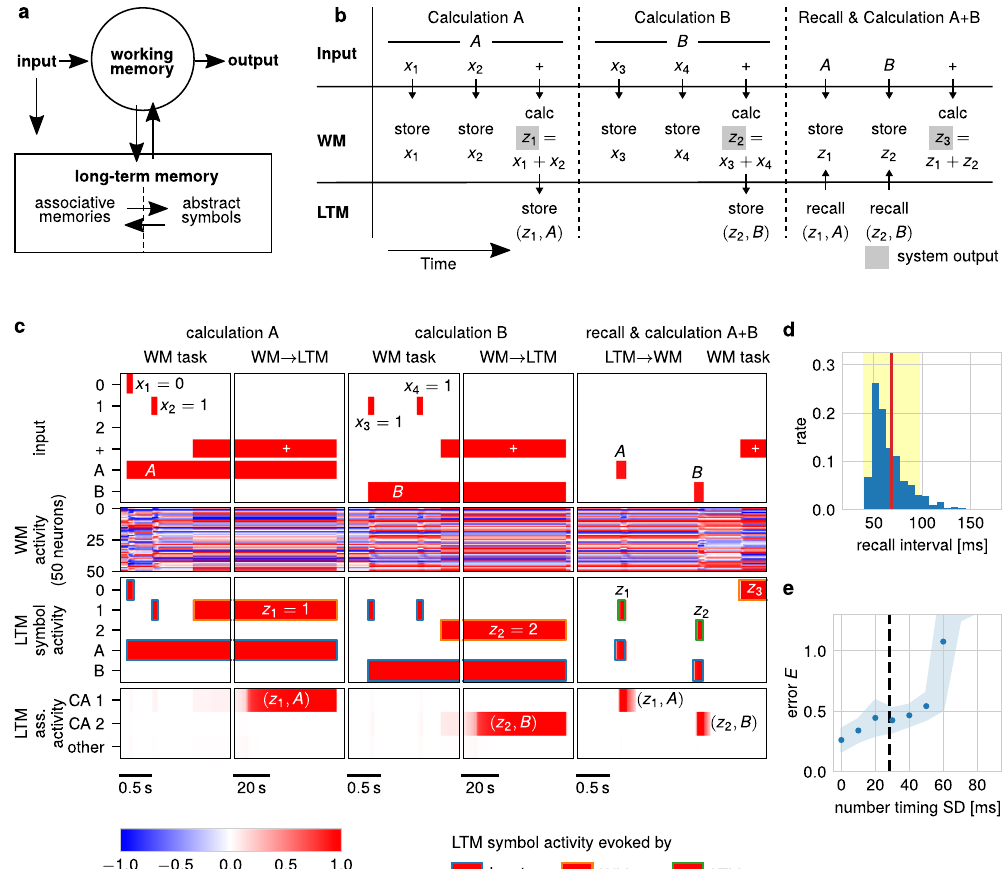
Figure 8. A multi-phase task requires the continuous interaction between WM and LTM. A WM network consisting of attractor states and transient dynamics enables the reliable interaction with an LTM network to solve a complex multi-phase task. Details see main text. ( a ) The external input is projected into WM and LTM. For simplicity, the LTM area is separated into two compartments: the first stores abstract symbols and the second forms input-dependent associations between these symbols. ( b ) Multi-phase task and information flow between input, WM, and LTM. ( c ) External inputs, activities of 10% of the N G = 500 WM-neurons, activities of the neurons within the LTM symbol area and activities within the LTM association area during the three phases. For the activities in the LTM symbol area, we indicate whether this activation is evoked by the external input, the WM, or from the LTM association area. ( d ) Distribution of the time intervals needed for the recall of the information stored in cell assemblies in the LTM-association area for equally distributed trials with 75% to 100% complete context signals. Here, the recall interval is defined as the time span between the onset of the external context stimulus and the point of time at which more than 50% of the neurons in the LTM-symbol area, representing the recalled number, fire at rates higher than 90% of the maximum firing rate. The standard deviation of this distribution is approximately 28 ms. ( e ) Error of a purely transient network with N G = 500 neurons performing the summation task (third phase) with only variances in input timings from the LTM recall alone. According to ( d ), this source of unreliability alone already doubles the readout error (dashed vertical